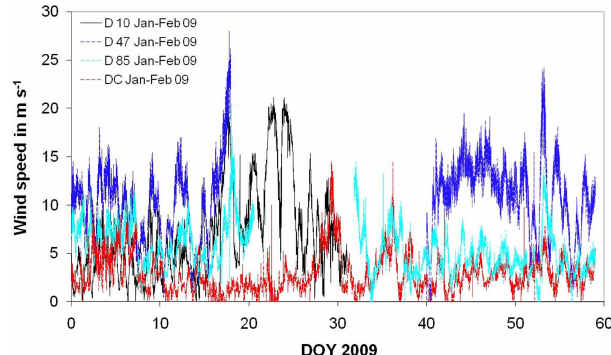
Fig. 13. Time series of wind speed along the traverse in January and February 2009. DOY=Day Of Year. Data from